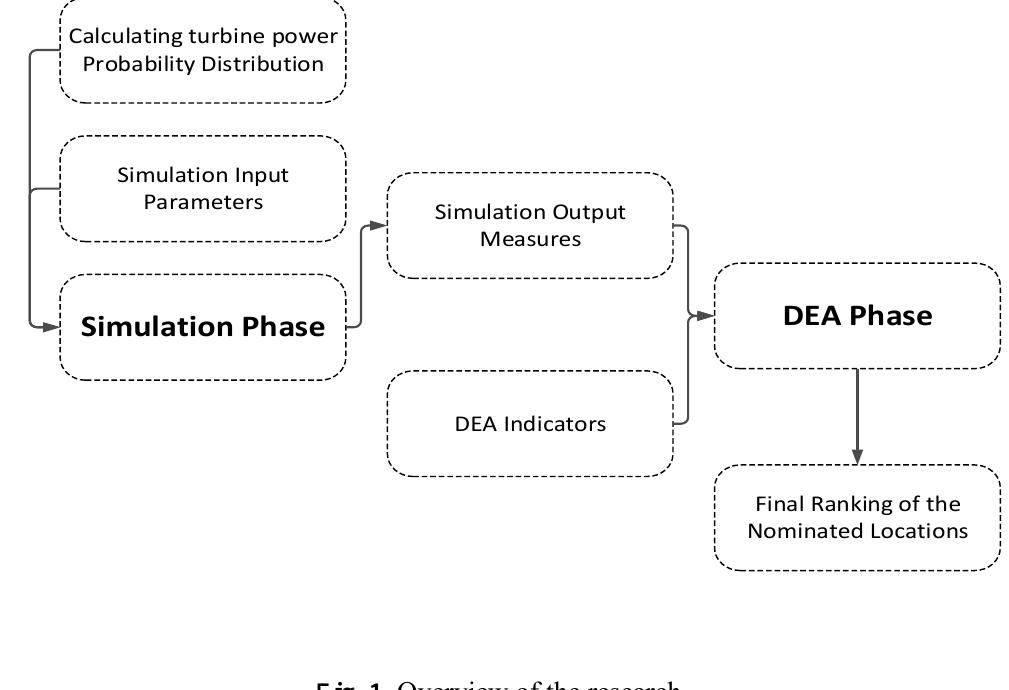
Fig. 1. Overview of the